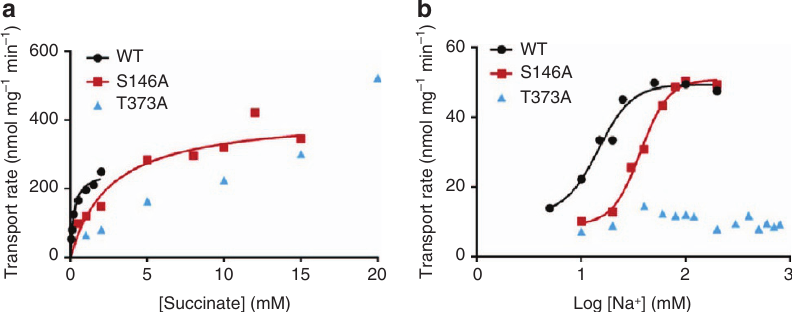
Figure 4 | Mutational effects on the transport properties of VcINDY. ( a ) The initial rates of succinate transport at 200mM external Na þ and pH 7.4 were plotted against external succinate concentrations. The data for S146A were averaged to fit to the Michaelis–Menten equation, yielding a K M of 2.57mM and a V max of 416nmolmg (cid:2) 1 min (cid:2) 1 . Transport for T373A remained unsaturable up to 20mM succinate, suggesting a K M of 4 270mM and precluding an accurate measurement of K M or V max . ( b ) The initial rates of succinate transport at 200 m M external substrate concentration ( B 8% of the K M for S146A) and pH 7.4 were plotted against the common logarithm of external Na þ concentrations. The data for S146A were averaged to fit to the Hill equation, yielding a Hill coefficient of 3.2 and a K 0.5-Na of 36.9mM. T373A-mediated transport of succinate lacked Na þ -dependence within the tested range (up to 800mM), suggesting that the K 0.5-Na for T373A is 4 800mM. Similar observations were made with 500 m M ( B 20% of the K M ) and 4mM external succinate for S146A and T373A, respectively. At 500 m M succinate, the data for S146A revealed a Hill coefficient of 3.1 and a K 0.5-Na of 47.6mM. For comparison, the data for VcINDY were plotted to highlight the functional consequences of mutations in Na1 and